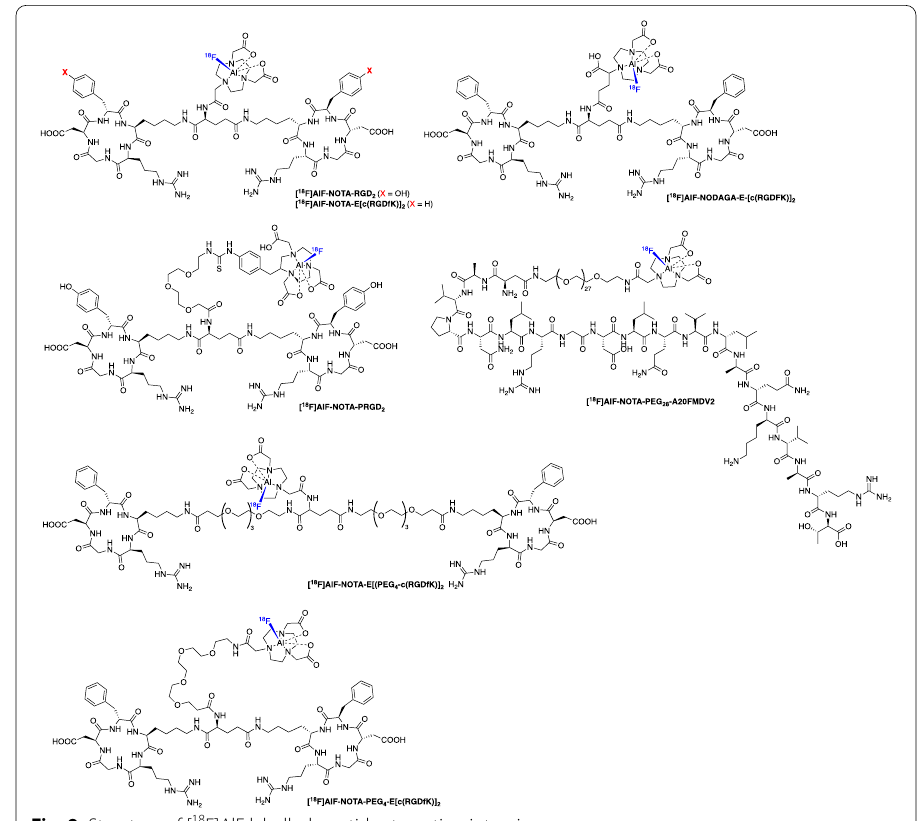
Fig. 9 Structure of [ 18 F]AlF labelled peptides targeting